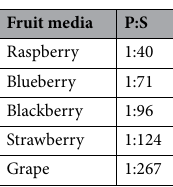
Table 1. Fruit media protein and sugar (P:S) content ratios